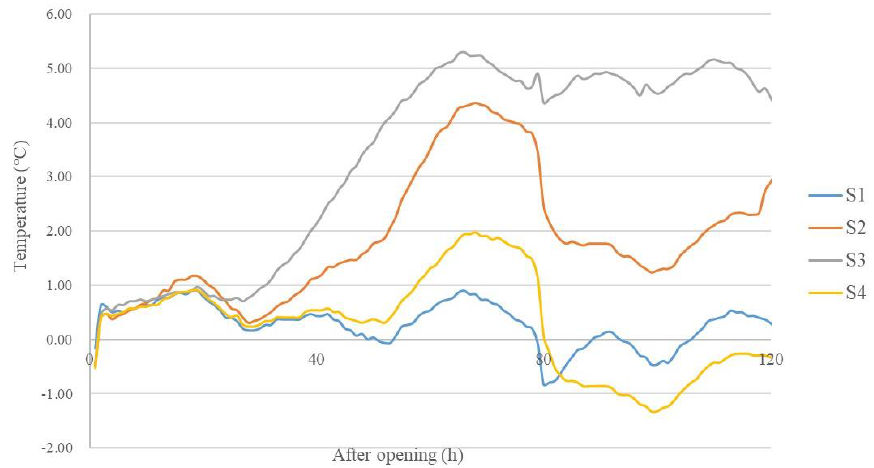
Figure 6. Temperature dynamics of silage reaching above-ambient temperature during aerobic exposure (n = 3). S1, silage collected from Erdos; S2, silage collected from Baotou; S3, silage collected from Ulanqab; S4, silage collected from Hohhot.